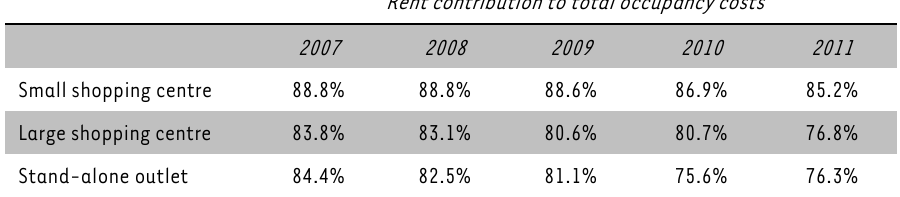
TABLE 4: Rent contribution to total occupancy cost by retail format